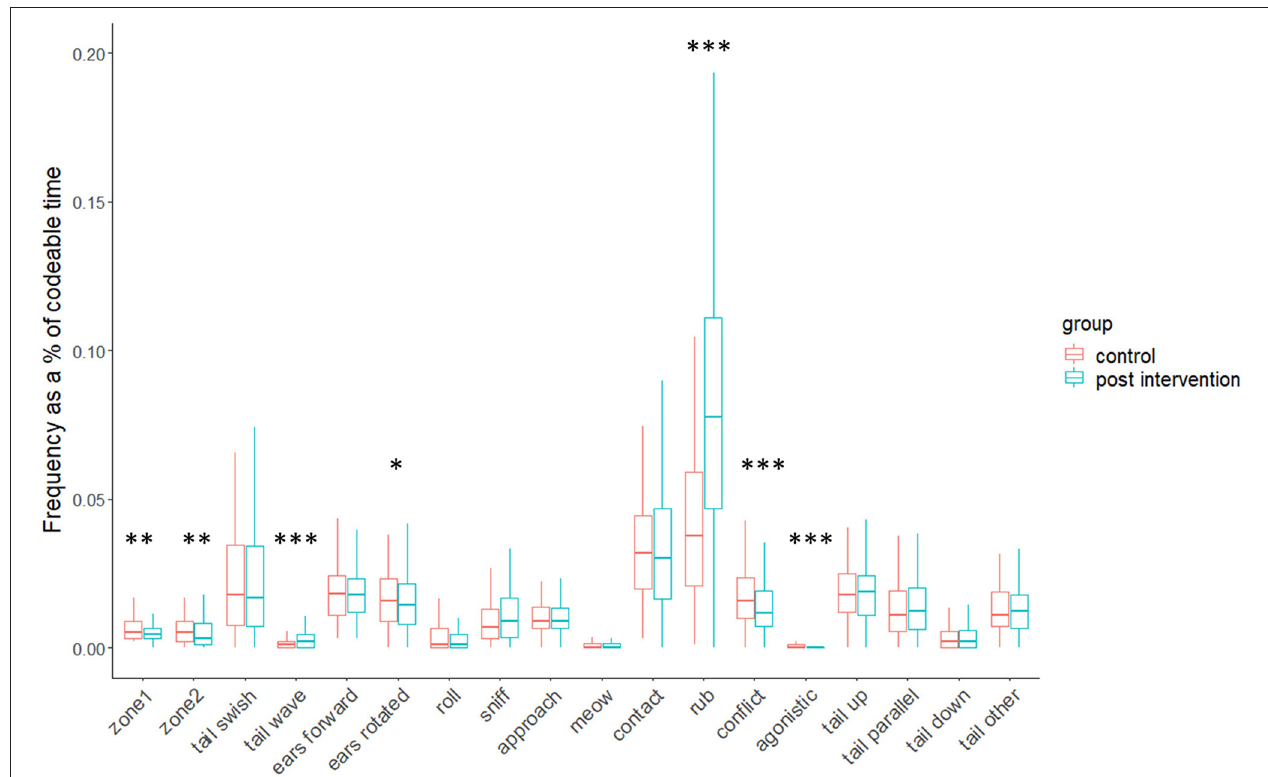
FIGURE 3 | Boxplots of cats’ average (frequency based) behavioural responses for control and intervention conditions (* p < 0.05, ** p < 0.01, *** p < 0.001).